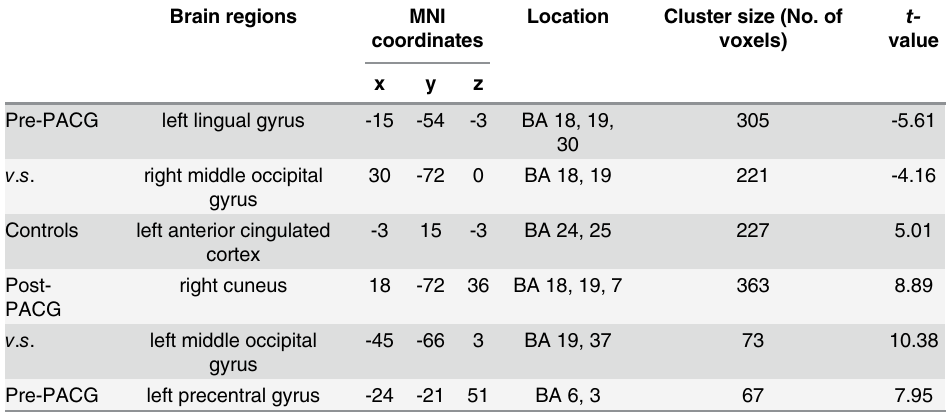
Table 3. Brain areas with significantly different DC between Pre-PACG patients v . s . Controls and between Post- v . s . Pre-PACG patients ( p < 0.05, GRF corrected). Brain